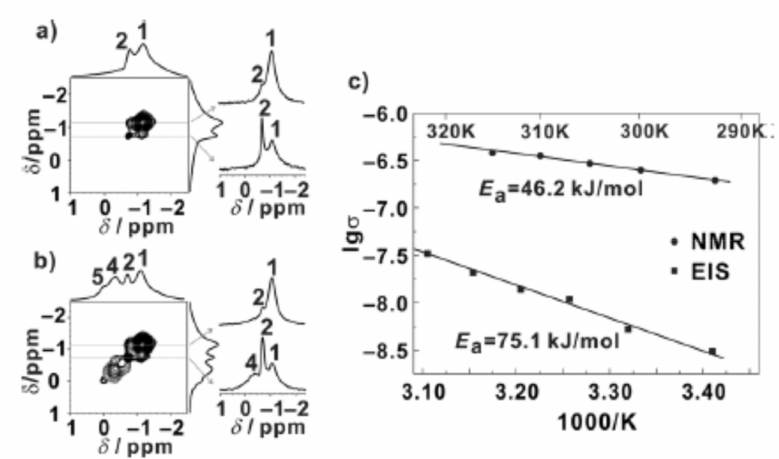
Figure 16. 7 Li EXSY spectra of PEO-LiAsF 6 in cyclodextrin nanochannels (14 T, 5 kHz MAS) with a mixing time of 300 ms. Spectrum ( a ) was collected with no dipolar coupling and showed correlation between the PEO and the interface. Spectrum ( b ) was collected with dipolar coupling where corre- lation between the interface and the cyclodextrin layer is observed. Activation energies calculated based on EXSY NMR data and electrochemical impedance spectroscopy (EIS) data ( c ). Reprinted with permission from [112]. Copyright 2014 Wiley and